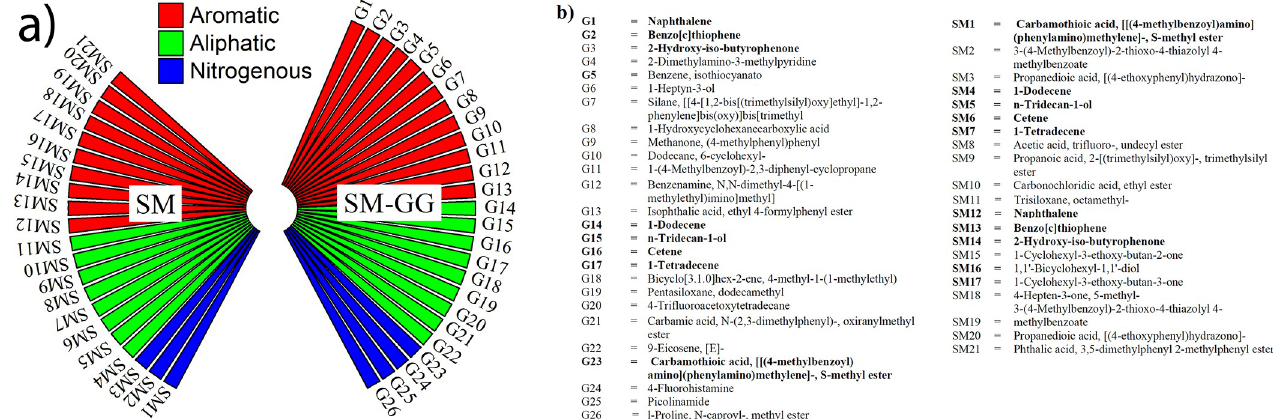
Fig 9. a) GCMS profiling for different combination of growth media namely SM without any media additives, SP-GG supplemented with guar gum, inoculated with S. pasteurii under flask condition after 6 days of incubation. SM represent for the treatment of SM without supplementation of guar gum whereas GG for the guar gum supplementation. Hatched column representing common compounds in both treatments. b) Showing name of the metabolites obtained from